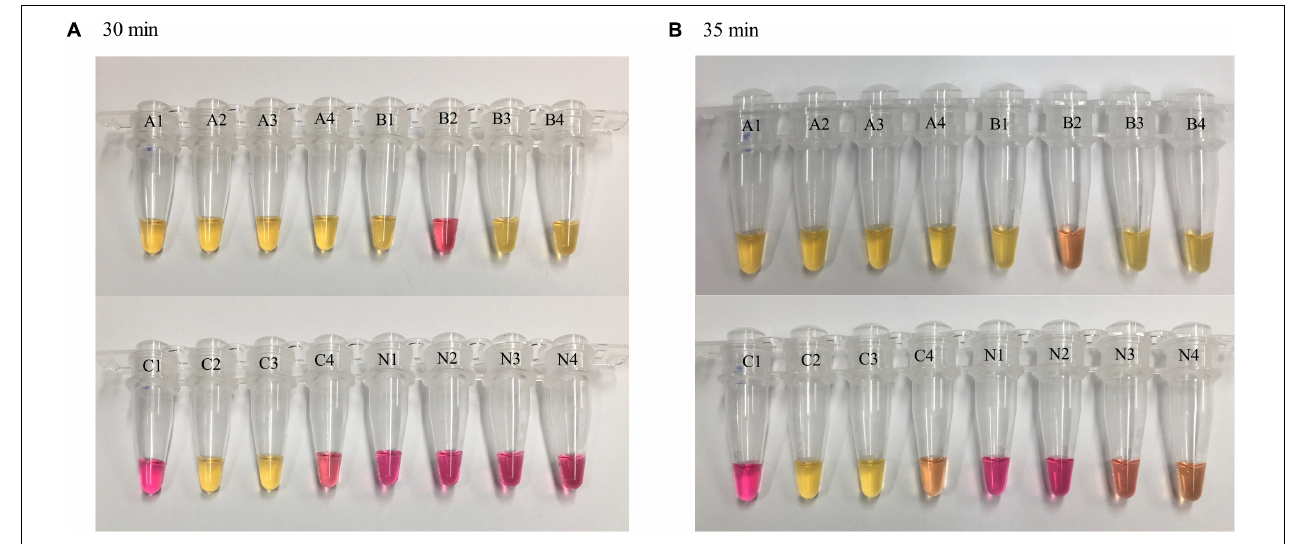
FIGURE 2 | Loop-mediated isothermal amplification reaction time and visual observations of color change. LAMP reactions with different concentrations of Y. pestis DNA were carried out on a dry bath heater. Four replicates were tested for each concentration and negative control. At 30 min (A) , color change was observed in four of four replicates of reactions with a DNA concentration of 0.2 pg (as well as higher concentration, not shown here) and in partial replicates of reactions with lower DNA concentrations (0.1 and 0.05 pg). Negative control remained unchanged; at 35 min (B) , a minor color change was observed in negative control (N3 and N4). A = 0.2 pg, B = 0.1 pg, C = 0.05 pg, N = negative